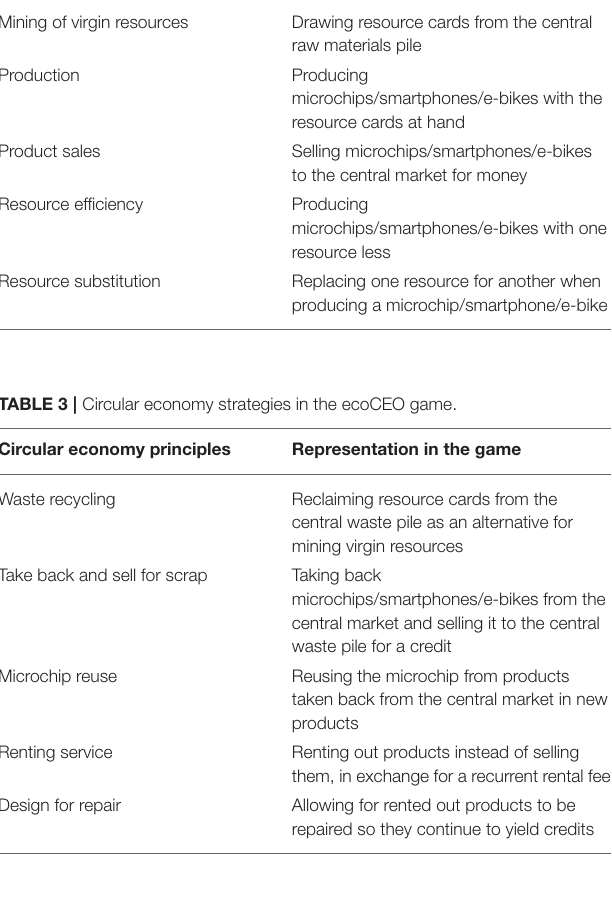
Table 3 provides an overview of the circular economy principles represented in the